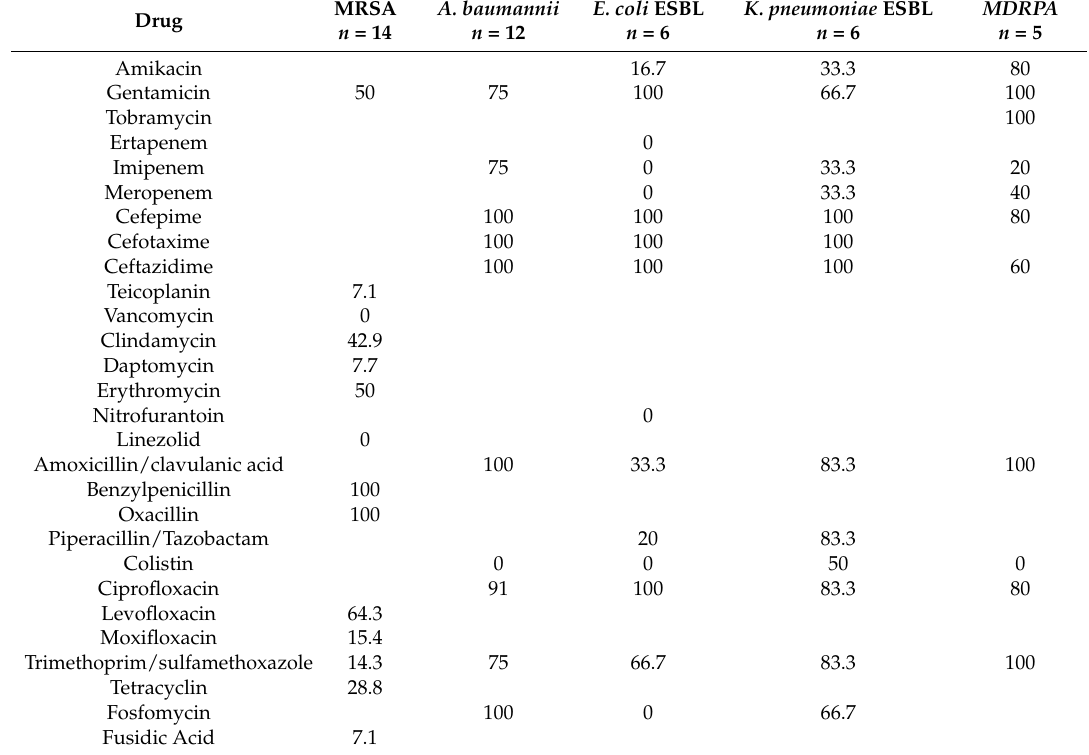
Table 3. Antibiotic resistance pattern of MDROs (% of resistance). Blank: data not available. MRSA = methicillin-resistant; ESBL = positive to the production of extended-spectrum beta-lactamase; MDRPA = multidrug resistant P. aeruginosa . n represents the number of